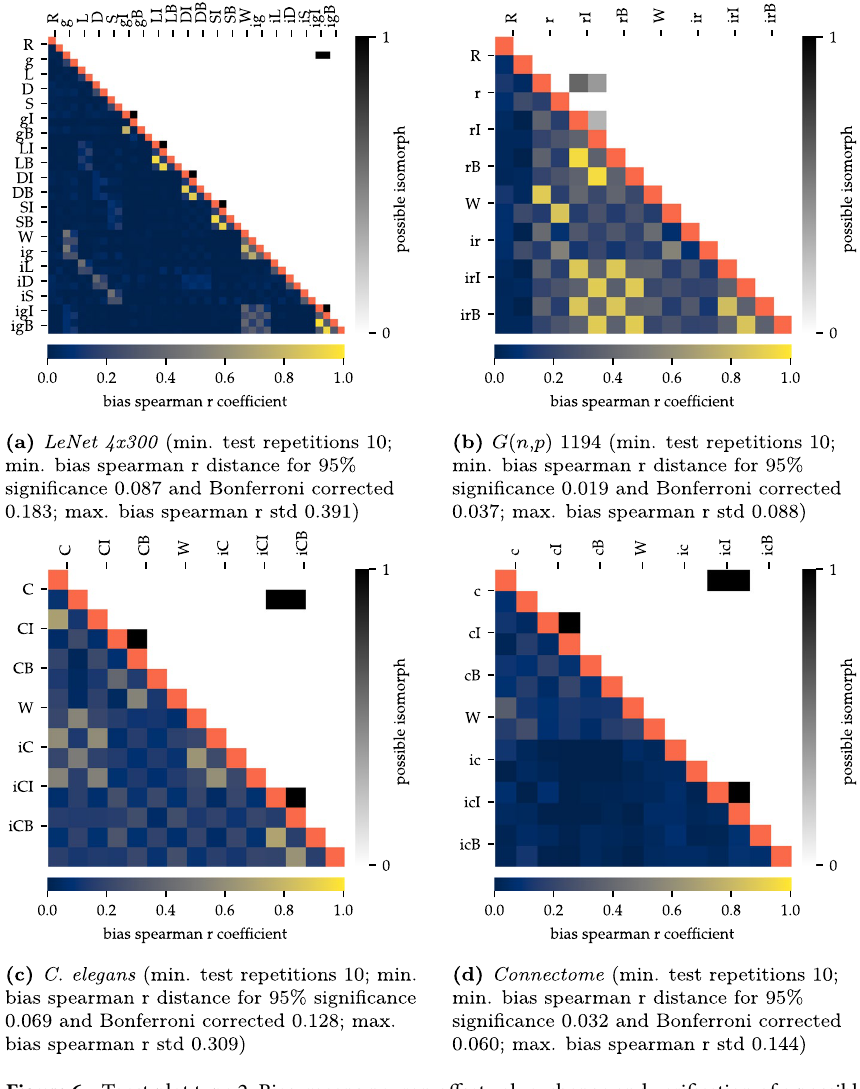
Figure 6. Toast plot type 2: Bias, means neuron offset value, change and verification of a possible existing isomorphism during learning and between different initial states. Identical tests marked red. Every mark consists of the configuration after 30 epochs training for MNIST and Fashion-MNIST respectively. Toast plot ( a ) shows the LeNet 4x300 , ( b ) G(n,p) 1194 , ( c ) C. elegans 26 and ( d ) the human connectome 27 . The majority of dark blue coloring in the lower left toast clearly show the comprehensive change in the bias value that have taken place in each artificial neuron. The upper right toasts show the results of the isomorphism test, which states the possibility that a graph could be isomorph. In most cases the calculation excluded this. The minimum distances for a 95% significance are based on t-test. The minimum distance for a 95% significance for the possible isomorphism is 0.9 based on binomial test R—reference, g—Glorot, L—lightning , D—dense diversity, S—sparse diversity initialization; c—connectome, C— C. elegans ; I—iterative pruning, B—bio pruning; W—winning ticket, i—structure